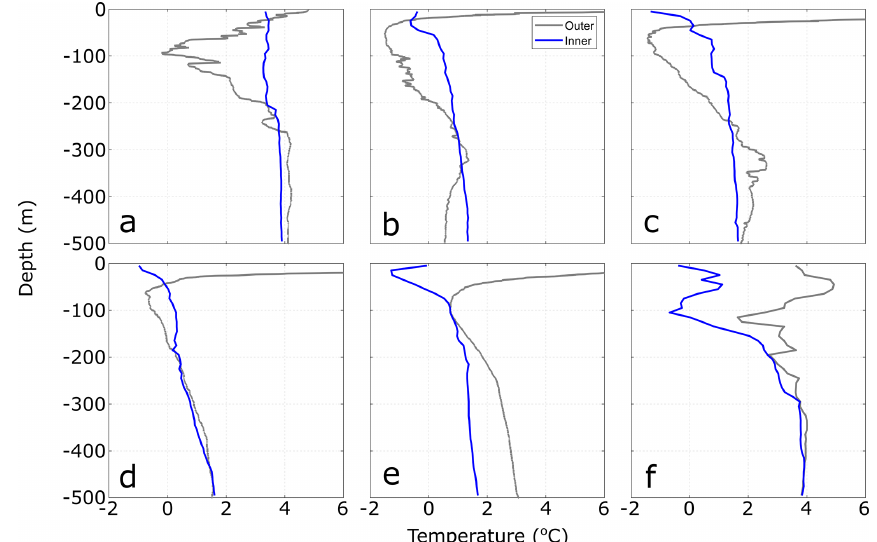
Figure 8. Fjord temperature profiles from the Oceans Melting Greenland project (https://omg.jpl.nasa.gov/, last access: 14 April 2020). The blue lines are profiles acquired within the fjord, close to tidewater glacier termini, and the grey lines are acquired at or beyond the fjord mouth. Fjords (or nearest glacier) shown are (a) Sermilik Fjord, (b) Daugaard-Jensen, (c) Upernavik Isstrom, (d) Nunatakassaap Sermia Fjord, (e) Ilulissat Isfjord, and (f) Timmiarmiut Fjord. Data are available from: https://omg.jpl.nasa.gov/portal/data/OMGEV-AXCTD,